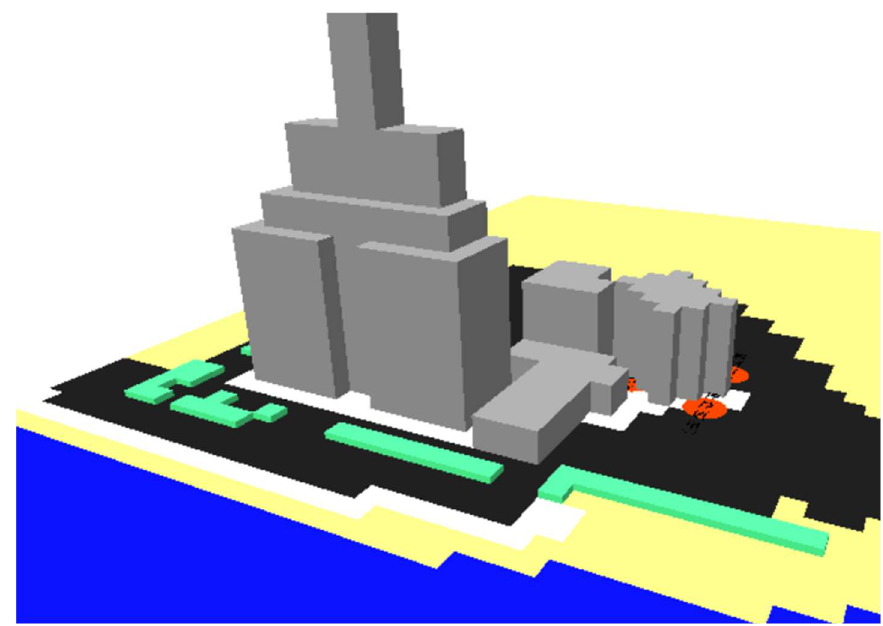
Figure 4. The ENVI-met 3D model of the ASU campus.